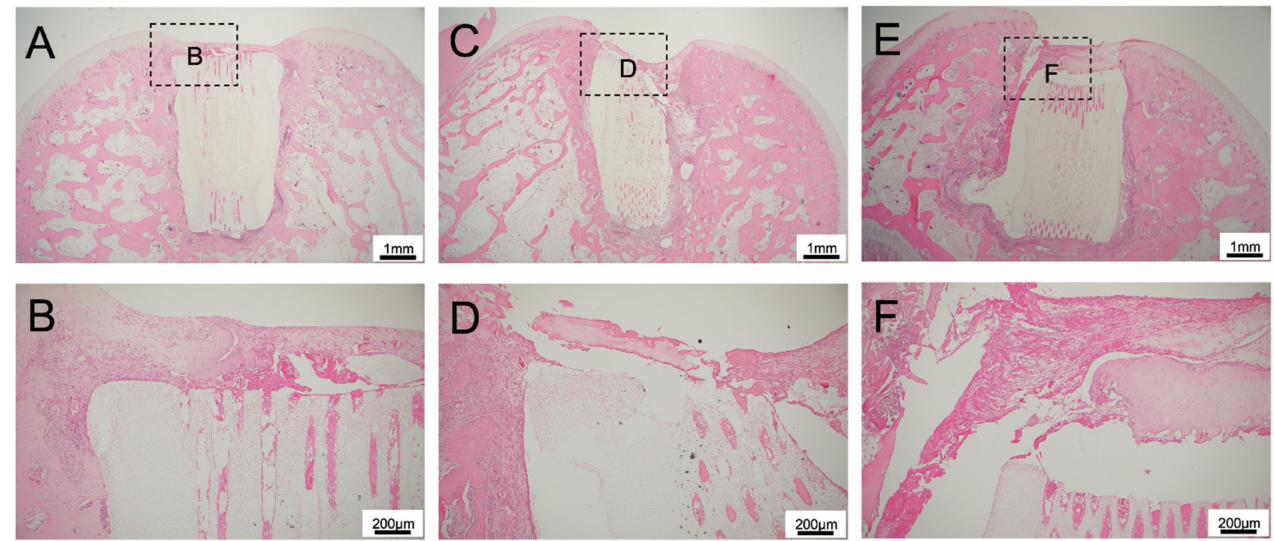
Figure 2. Histological findings of 75TCP experiments. ( A ) Histological finding of the Matrigel-only group at low power magnification, and ( B ) Histological finding of the Matrigel-only group at high power magnification. ( C ) Histological finding of the BMP-2 with Matrigel group at low power magnification, and ( D ) Histological finding of the BMP-2 with Matrigel group at high power magnification. ( E ) Histological finding of the TGF- β +BMP-2 with Matrigel group at low power magnification, and ( F ) Histological finding of the TGF- β +BMP-2 with Matrigel group at high power magnification. In all experimental groups, Matrigel remained in the TCP pores, and no bone tissue formation was observed in the